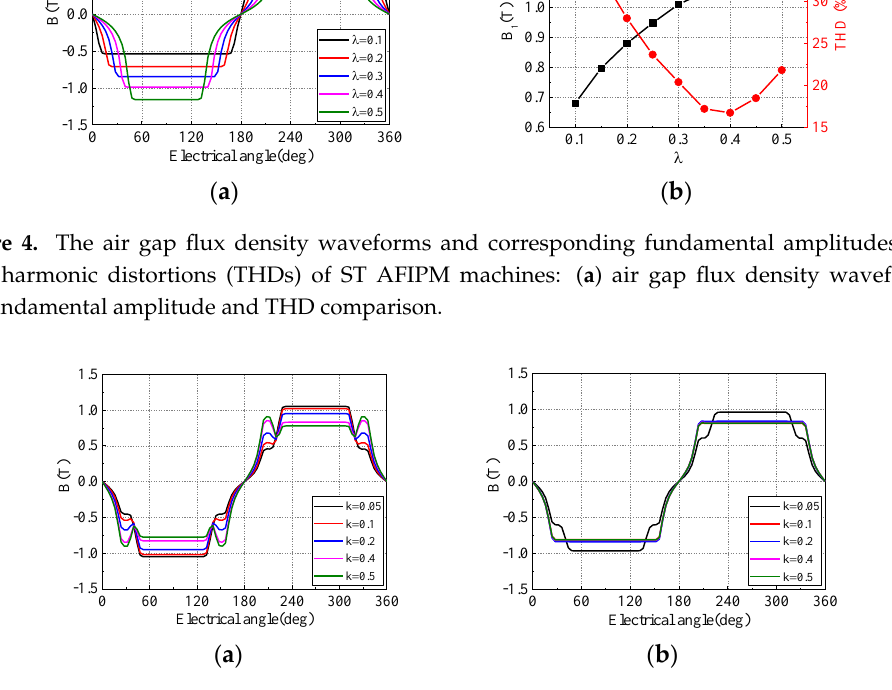
Figure 5. The air gap flux density waveforms of TLST AFIPM machines with and without flux barriers: ( a ) machine with flux barriers; ( b ) machine without flux barriers.